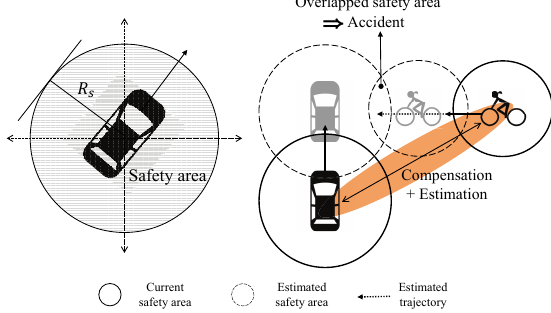
Figure 8. Safety area and collision